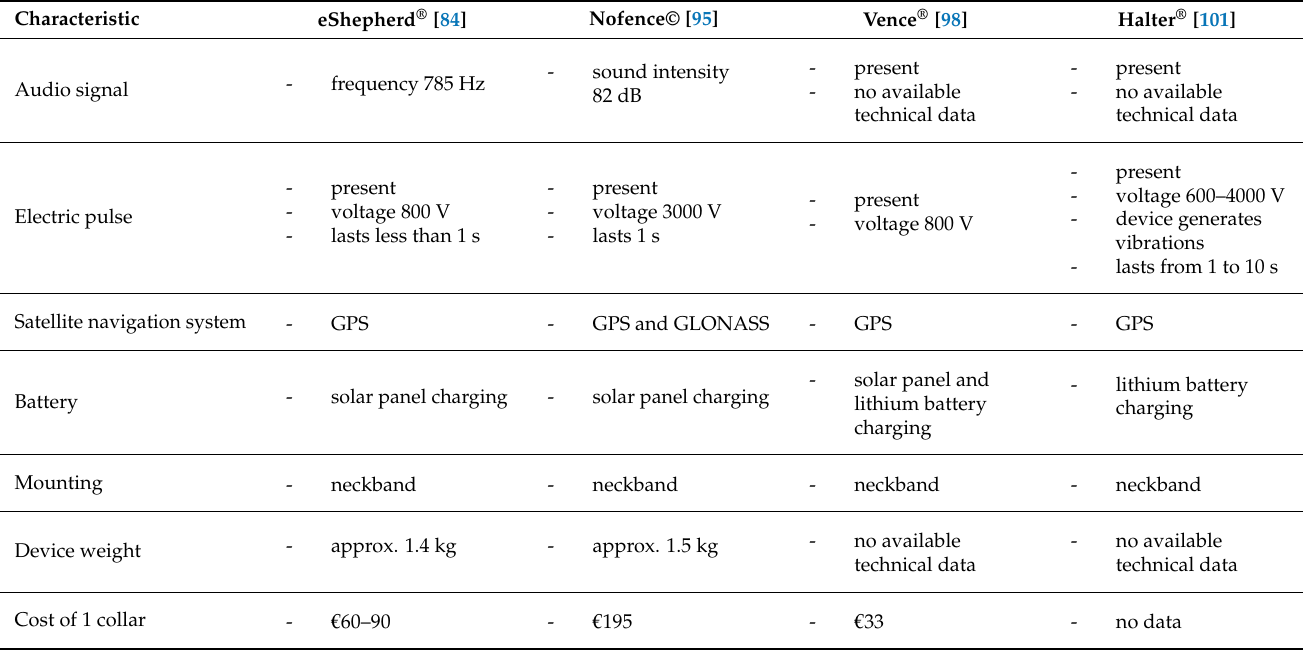
Table 2. Technical comparison of virtual fencing technologies used worldwide in ruminant feed- ing